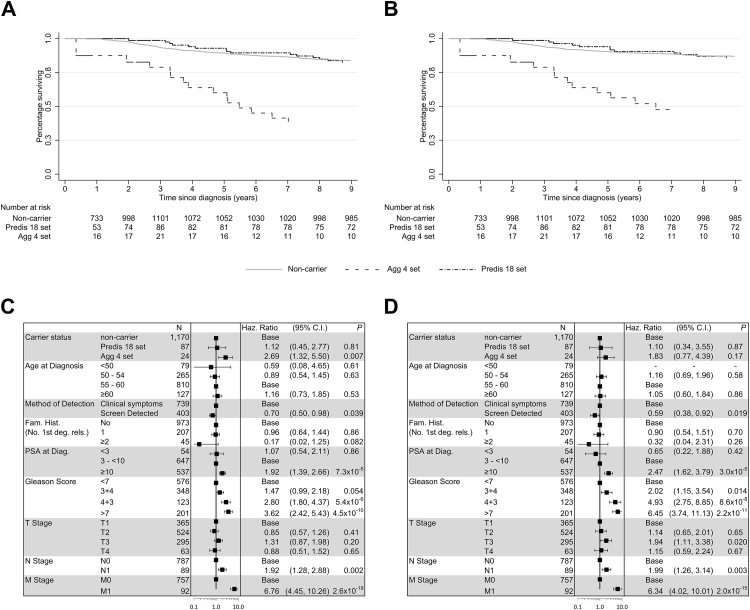
Gene set survival. Kaplan-Meier survival plots depicting (A) overall survival and (B) cause-specific survival. Multivariate Cox regression analysis of phenotypic features and gene set carrier status are shown for (C) overall survival and (D) cause-specific survival. Analyses were conducted using PCa cases only. CI = confidence interval; diag. = diagnosis; Fam. hist. = family history; Haz. ratio = hazard ratio; PCa = prostate cancer; PSA = prostate-specific antigen; 1st deg. rels. = first-degree relatives.